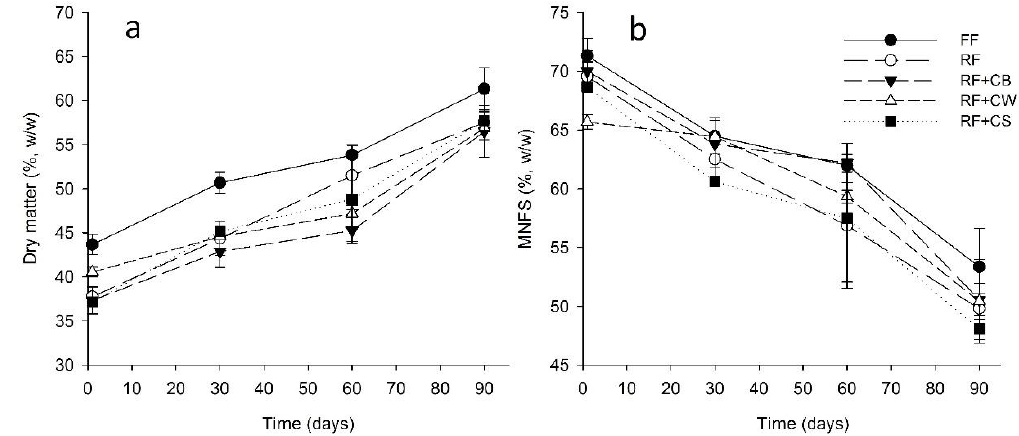
Figure 1. Dry matter ( a ) and moisture in non-fat solids (MNFS) ( b ) of tested cheeses over ripening. (FF): full-fat; (RF): reduced-fat; (RF + CB): reduced-fat with concentrated buttermilk; (RF + CW): reduced-fat with concentrated whey; (RF + CS): reduced-fat with concentrated second cheese whey. According to the Portuguese standard, NP-1598 [31], at the 30th day of ripening all cheeses could be considered as semi-soft (61–69% MNFS). At the 60th day, only FF and RF + CB cheeses maintained